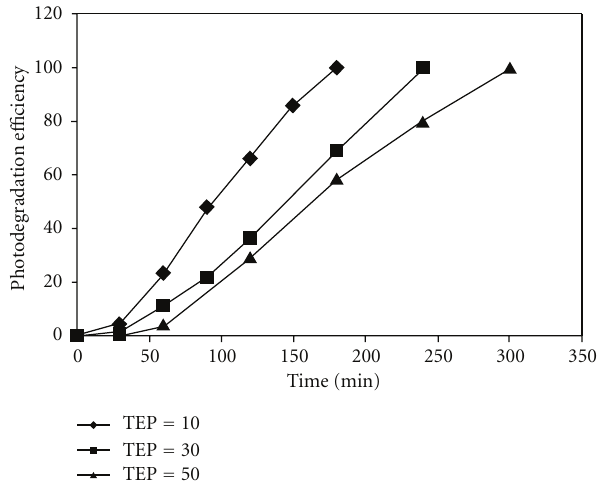
Figure 6: The kenetic rate of TEP (nano-TiO 2 = 400 mg/li and pH =